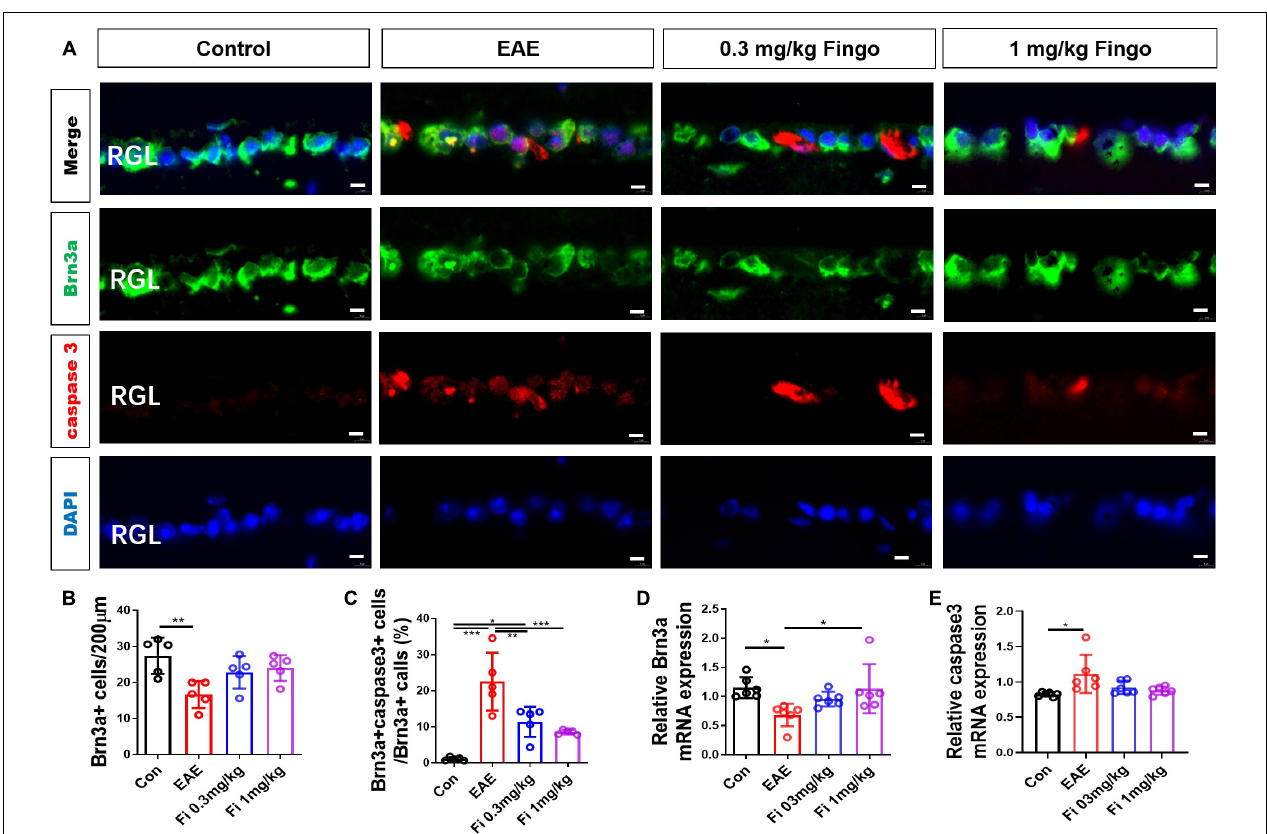
FIGURE 5 | Retina ganglion cell apoptosis with fingolimod treatment. (A) Retinal ganglion cells and apoptotic cells in the RGC were marked with Brn3a and cleaved caspase3; the apoptotic retinal ganglion cells were labeled with both antibodies. (B) Number of Brn3a+ cells in the RGC (length = 200 µ m). (C) Ratios of